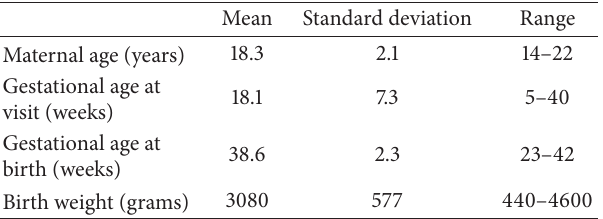
Table 1: Adolescent and young adult ages and pregnancy character-